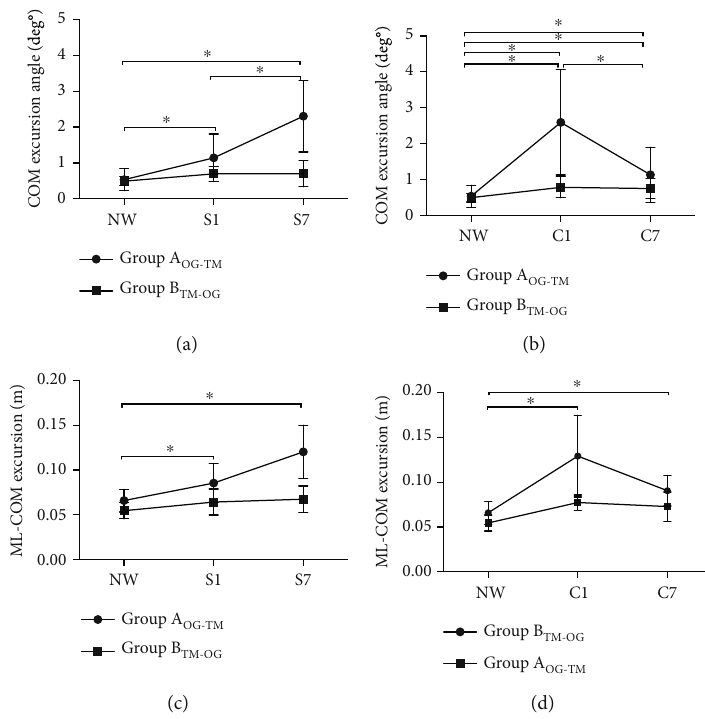
Figure 3: Between-group comparative analysis of the kinematic adjustments (COM excursion angle and ML-COM excursion) in response to the fi rst exposures to the VREs. (a) Mean and SD of the COM excursion angle for the natural walking trial (NW), fi rst snowy VRE trial (S1), and seventh snowy VRE trial (S7). (b) Mean and SD of the COM excursion angle for the fi rst natural walking trial (NW), fi rst crowded VRE trial (C1), and seventh crowded VRE (C7). (c) Mean and SD of the ML-COM excursion for the fi rst natural walking trial (NW), fi rst snowy VRE trial (S1), and seventh snowy VRE trial (S7). (d) Mean and SD of the ML-COM excursion for the fi rst natural walking trial (NW), fi rst crowded VRE trial (C1), and seventh crowded VRE trial (C7). Signi fi cant changes between trials ( p < 0 : 05 ) are indicated by ∗